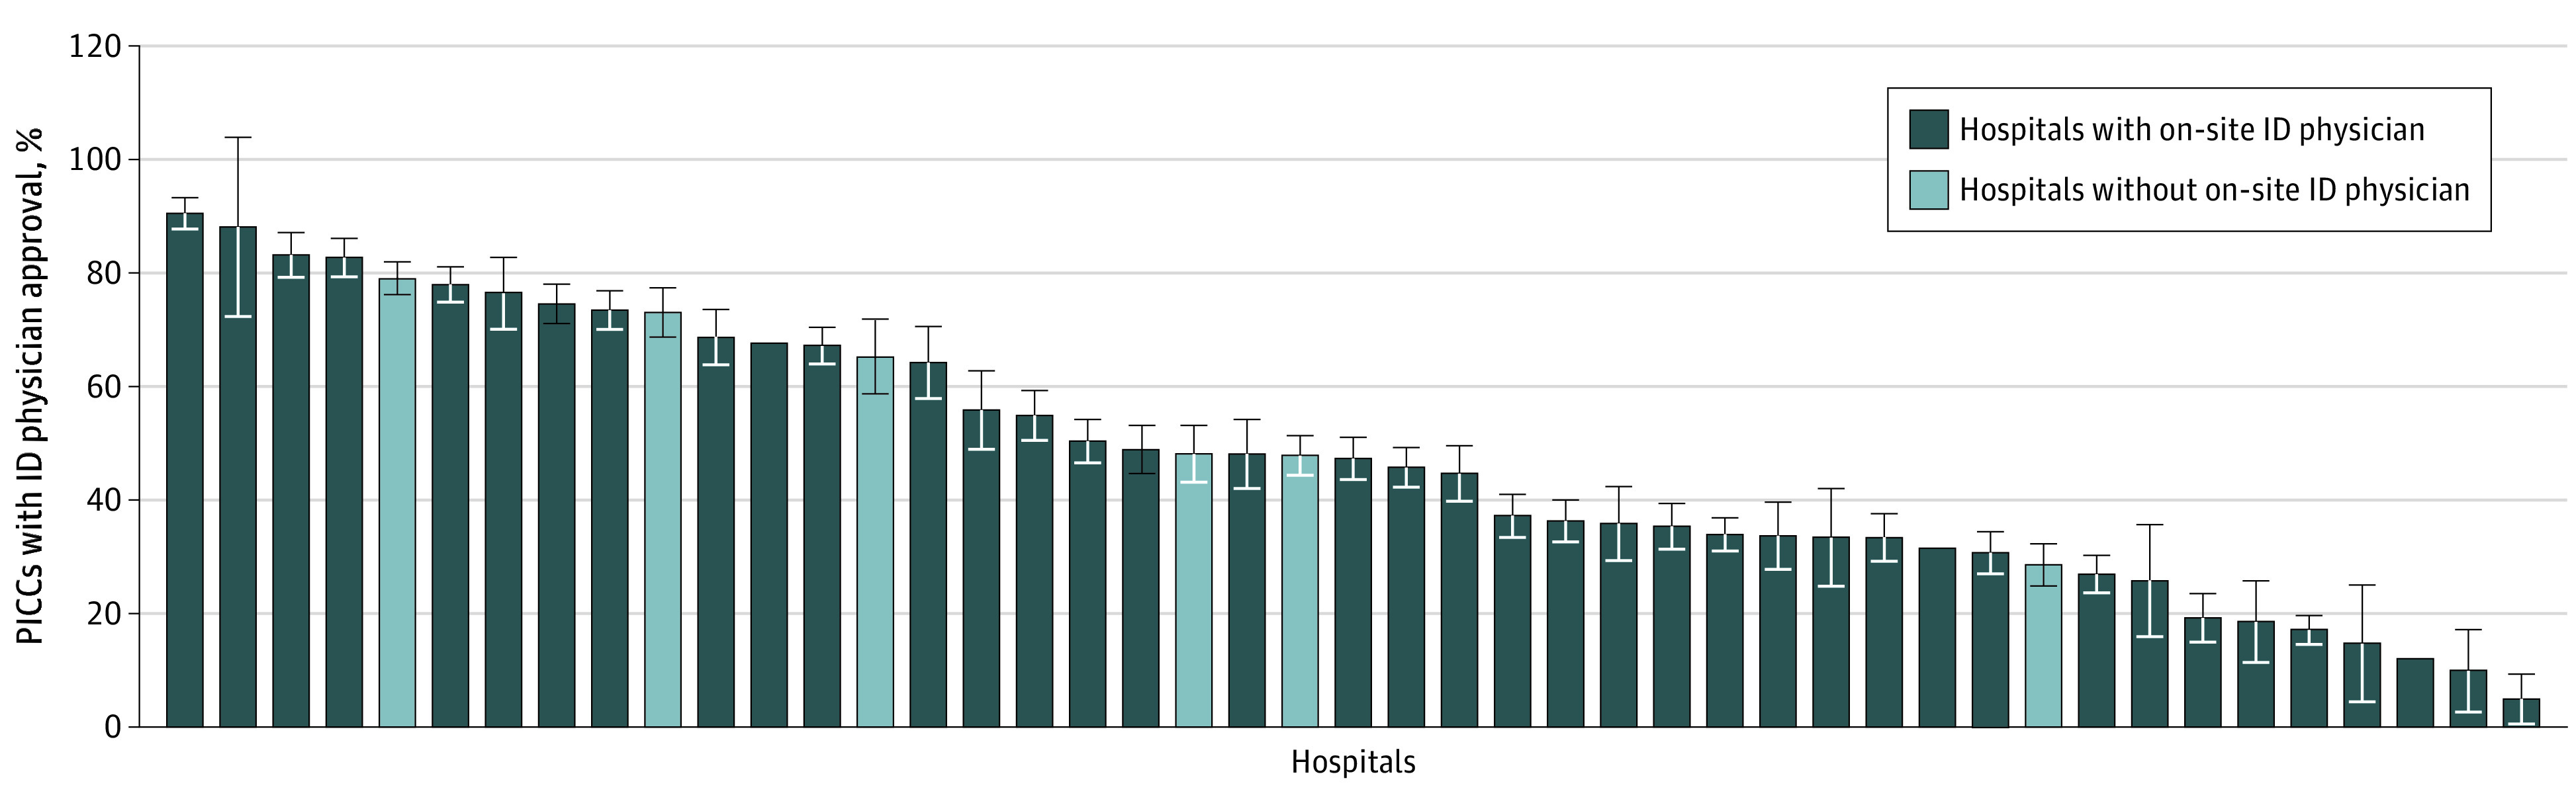
Proportion of Peripherally Inserted Central Catheters (PICCs) Placed for Intravenous Antimicrobials That Had Approval From an Infectious Disease (ID) Physician Prior to Placement, by Hospital (N = 21 317)Each bar represents 1 hospital. Not shown are 2 hospitals with less than 25 observations. Two hospitals also had no ID physician approvals (both lacked onsite ID physician availability). Error bars indicate 95% CIs.